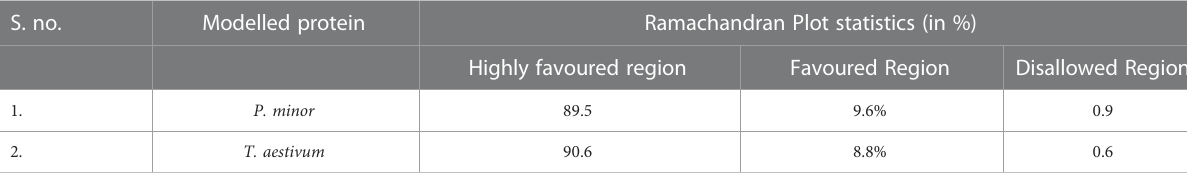
TABLE 2 Model validation for residue spatial arrangement through Ramachandran